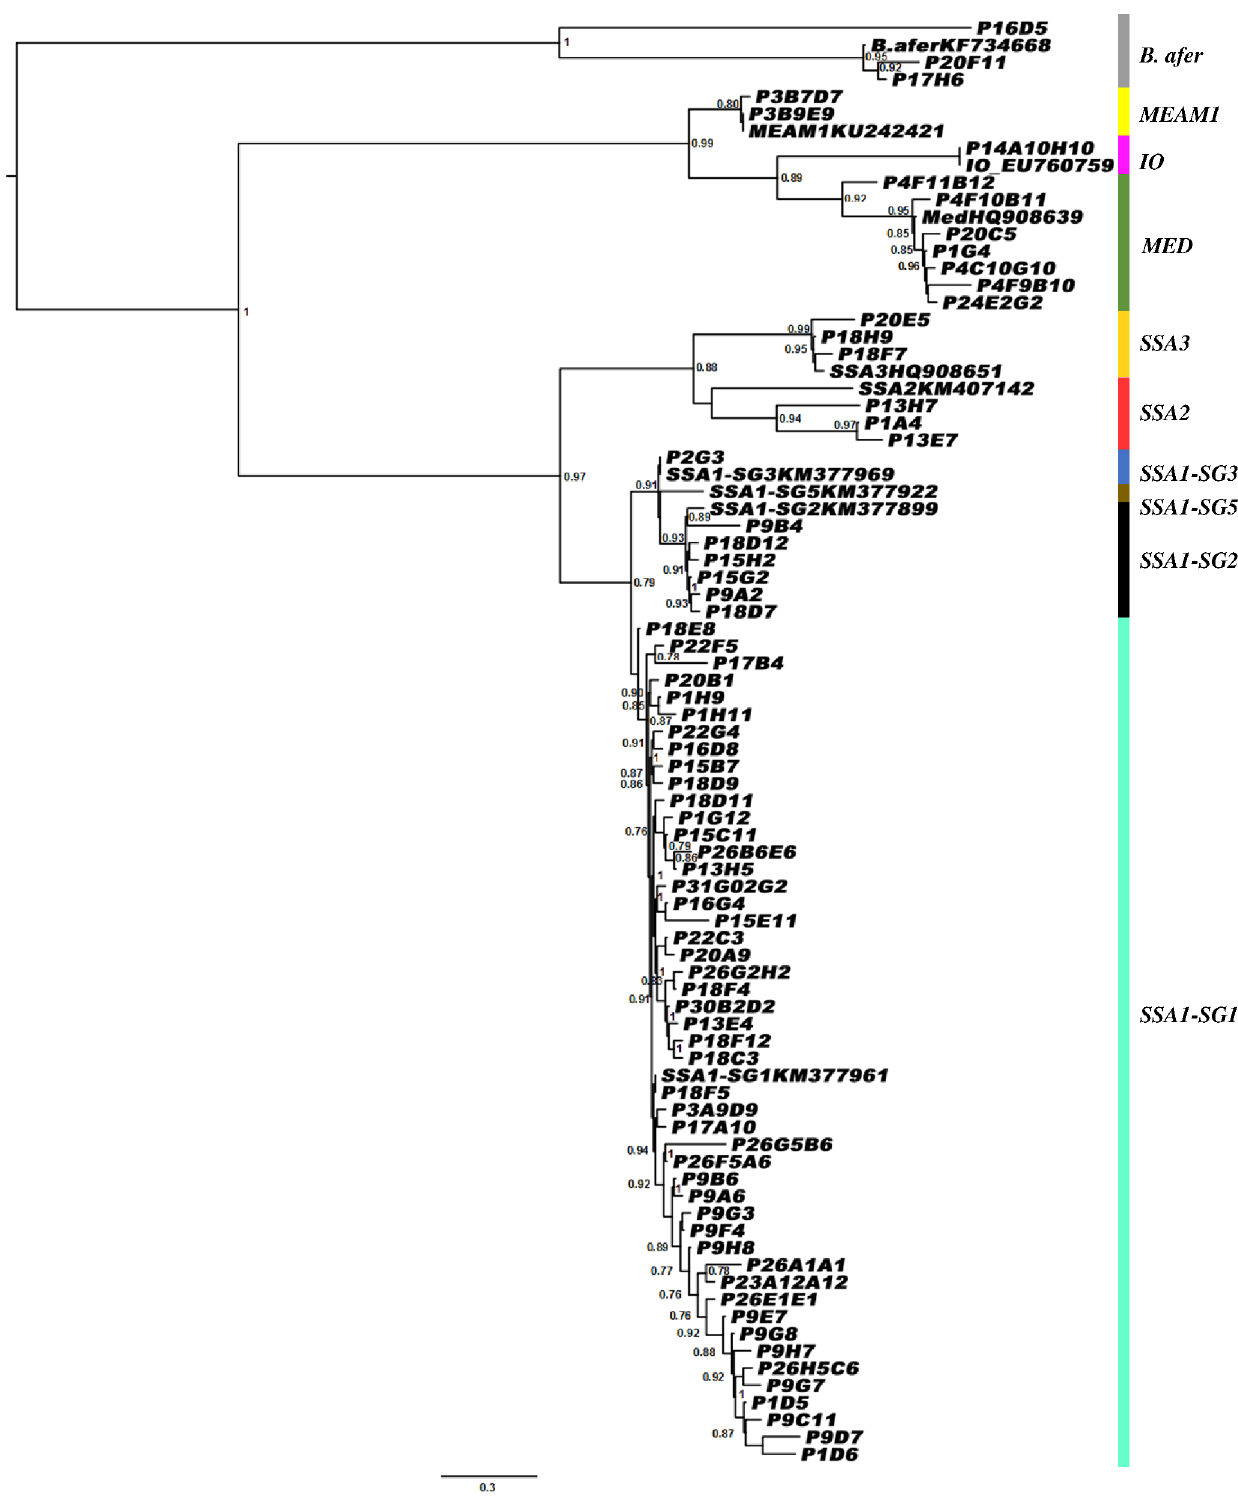
Fig 2. Phylogenetic tree indicating the relationships between the DNA sequences of 504 bp of the mitochondrial COI of B . tabaci for 74 unique sequences (see S1 Table) and those of a representative sampling of publicly available close sequences (Table 1). The tree was constructed using an approximate maximum likelihoodphylogeny. Branch support was calculatedby Shimodaira-Hasegawa-like local branch support (SH-like test).